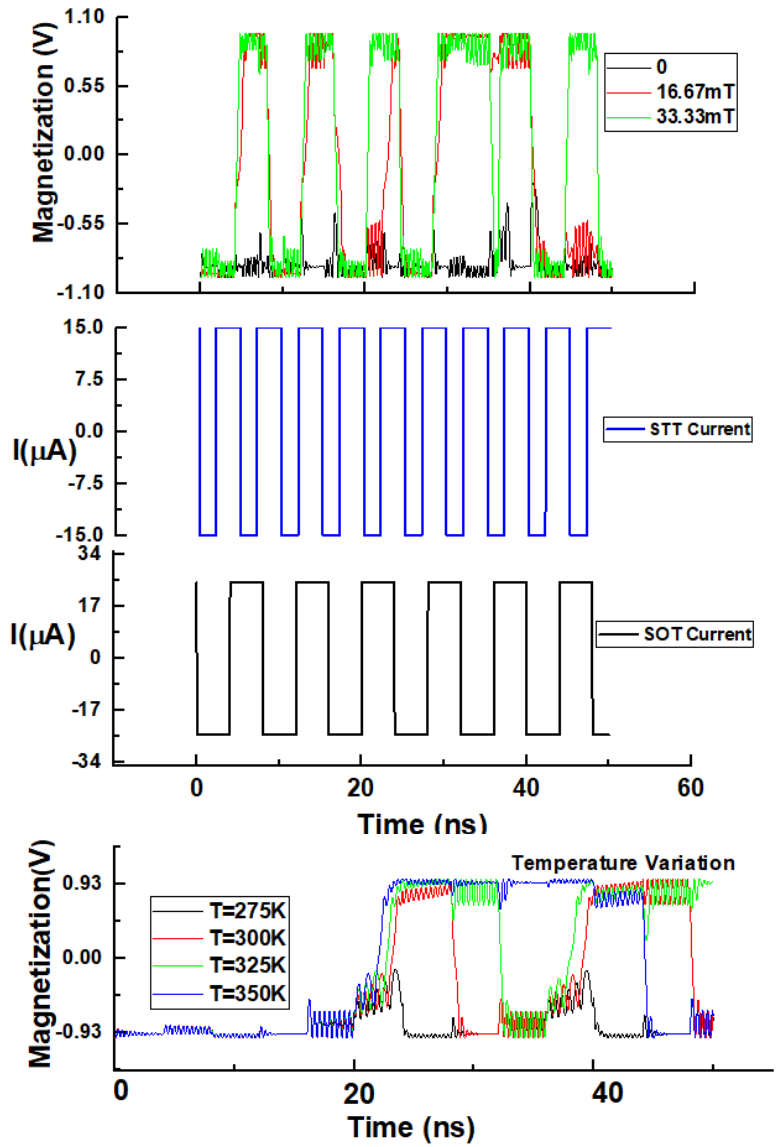
Figure 5. Free layer magnetization vs. applied external field and